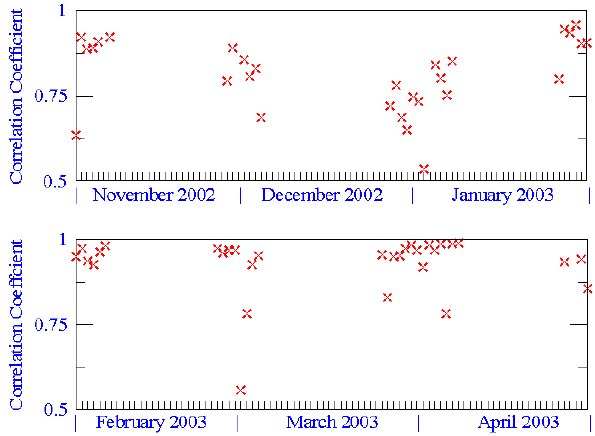
Fig. 2. The values of correlation coefficients between P 1 (2) and P 1 (4) lines of OH(8,3) band airglow are plotted for different nights during the period of